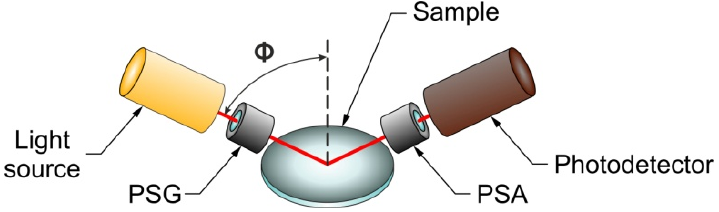
Figure 6. General scheme of MM ellipsometer.